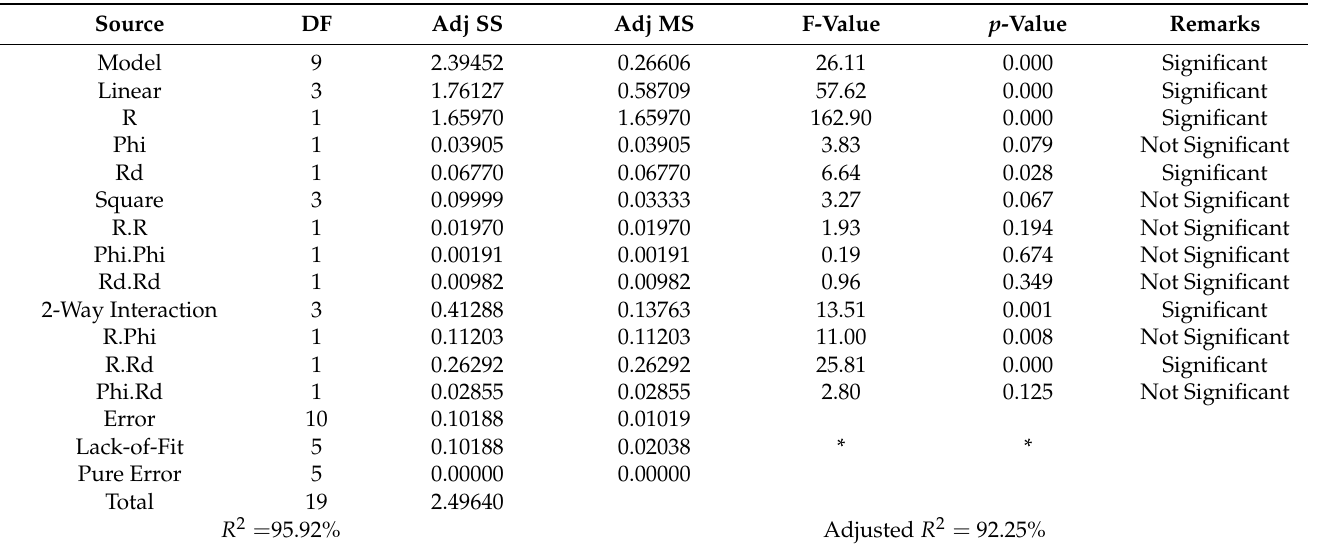
Table 6. ANOVA for Nu x ( − 1 )